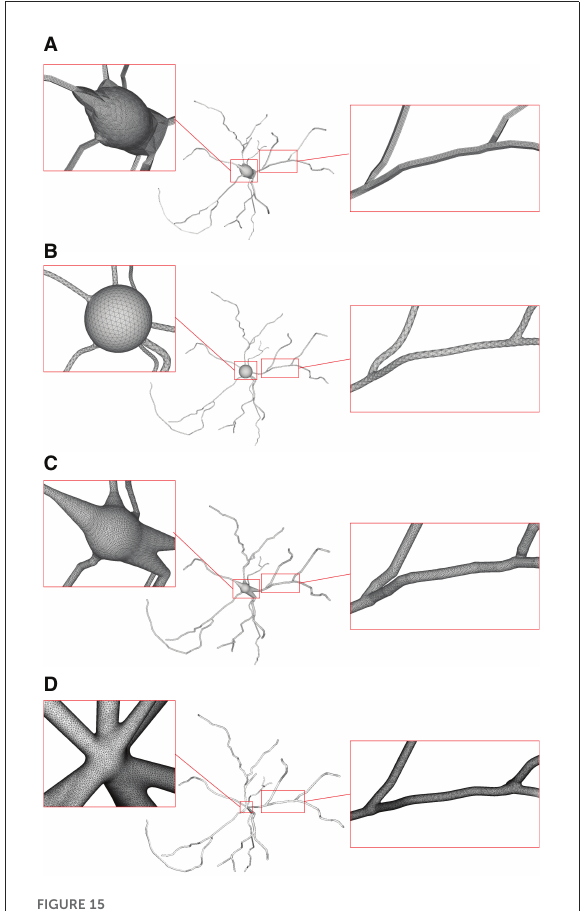
FIGURE15 Comparison of the generation of a same neuron using different approaches. Models generated using NeuroTessMesh (A) , AnaMorph (B) , Neuromorphovis (C) , and our proposed method (D) are shown,